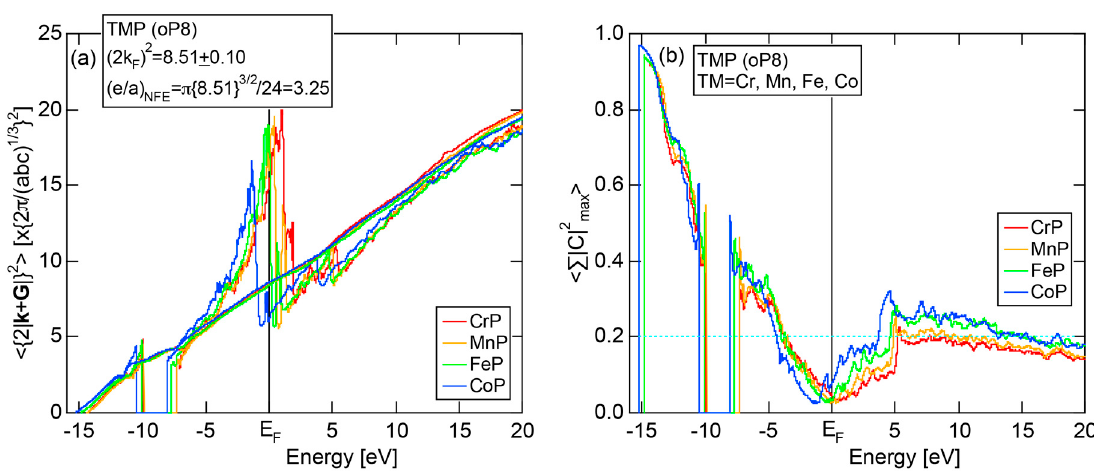
max2 max2 for TMP (TM = Cr, for TMP (TM = Cr, E E